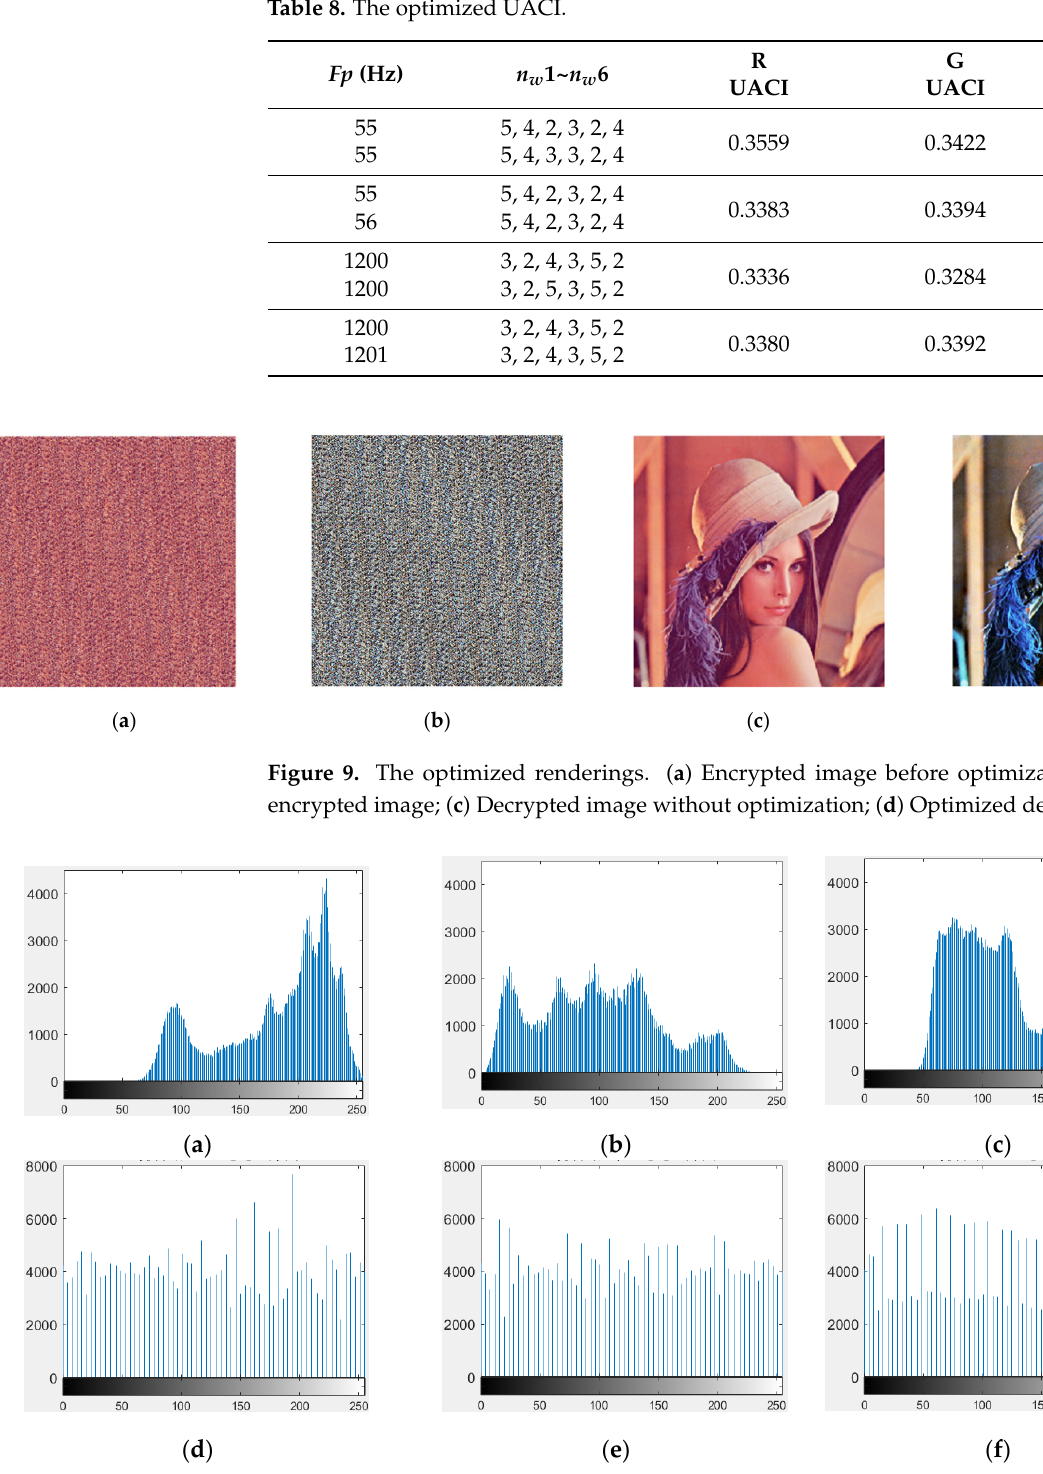
Table 8. The optimized UACI.